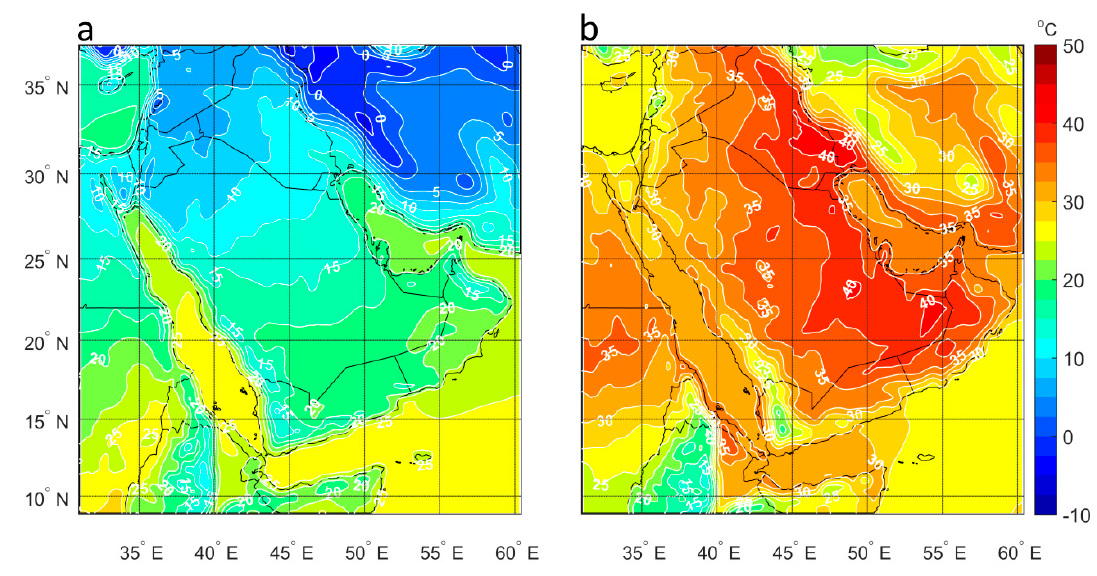
Figure 6. Mean 2 m temperature for January ( a ) and July ( b ).